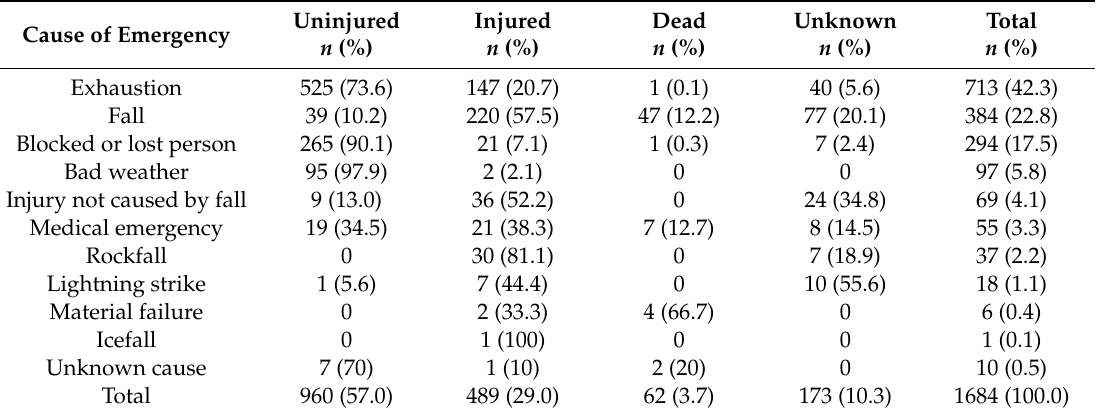
Table 2. Cause of emergency vs. injury classification on via ferratas in Austria from 1 November 2008 to 31 October 2018. Listed according to total frequency.